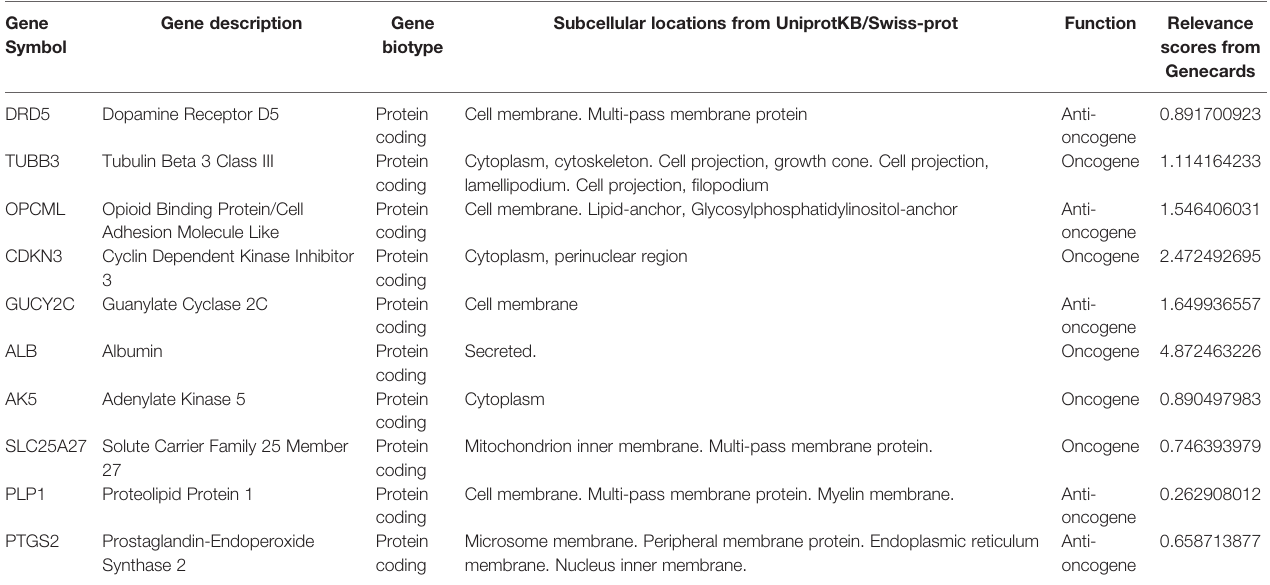
TABLE 1 | The basic information of investigative genes in this